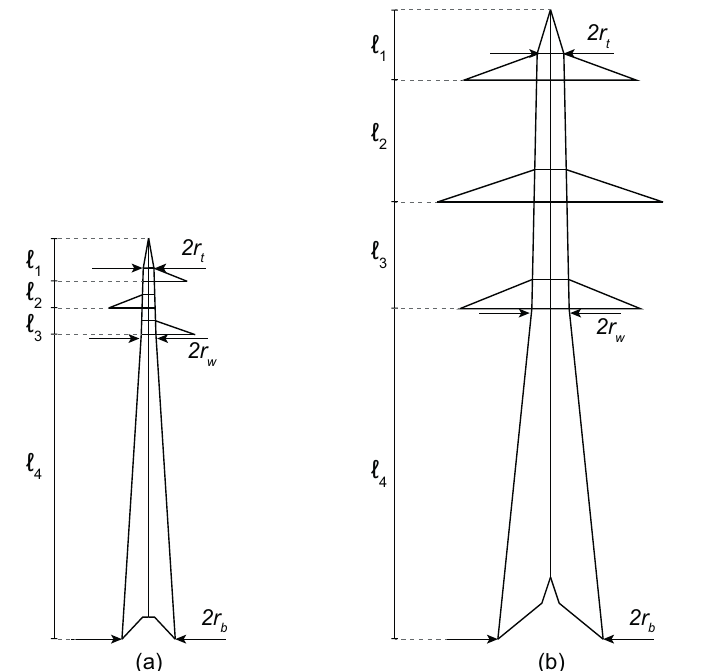
Figure 16. Typical towers for HV overhead transmission lines. ( a ) Rated voltage 132 kV; ( b ) Rated voltage 380